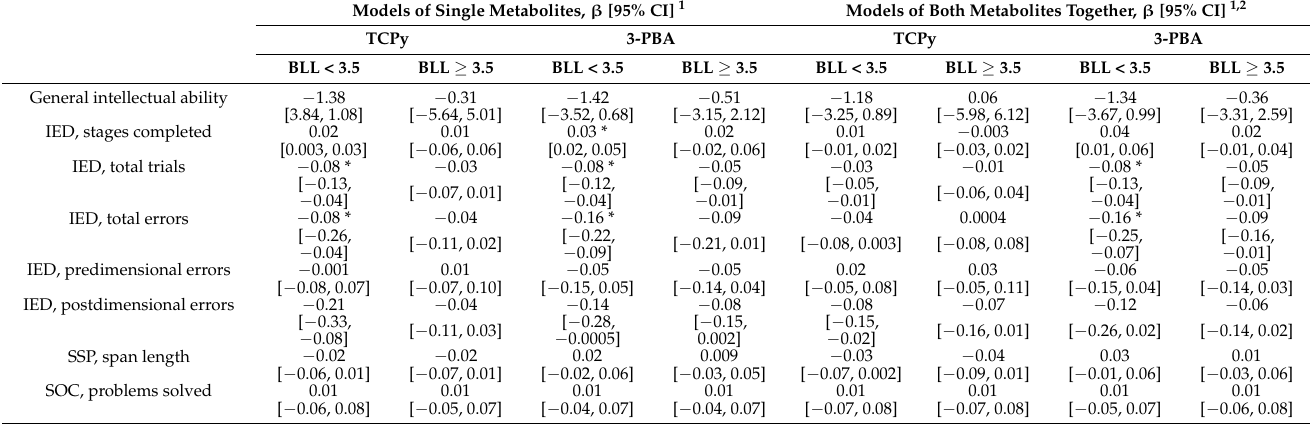
Table 4. Adjusted associations for natural log-transformed chlorpyrifos metabolite TCPy (3,5,6- trichloro-2-pyridinol) and pyrethroid metabolite 3-PBA (3-Phenoxybenzoic acid) concentrations in urine with general intellectual ability measured by the Woodcock–Muñoz Battery, and domains of executive functions measured by the CANTAB in the multiple imputed samples ( n = 241) stratified by blood lead levels (<3.5 and ≥ 3.5 µ